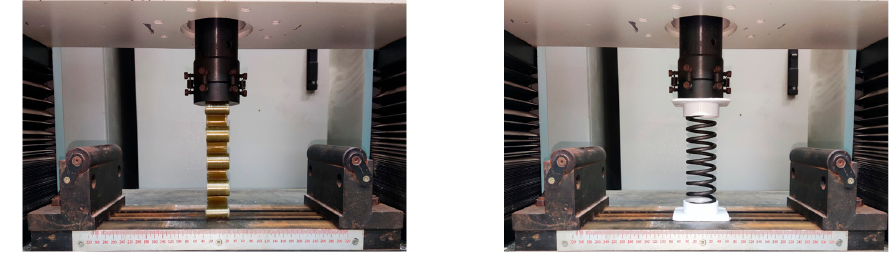
Figure 6. Schematic diagram of finite element simulation analysis model setting, ( a ) Finite element model of wave spring, ( b ) Simulation boundary condition settings.